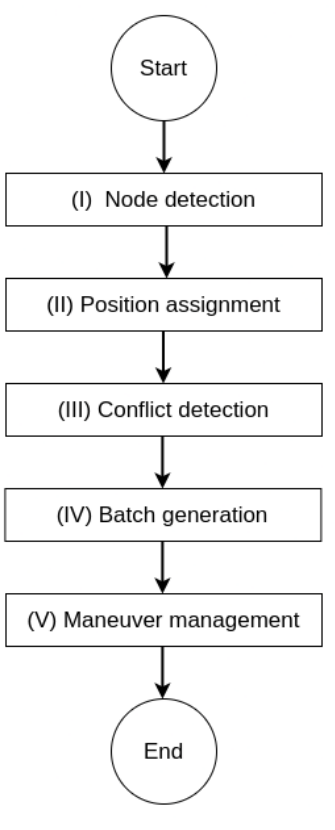
Figure 1. Flowchart representing the various stages of the